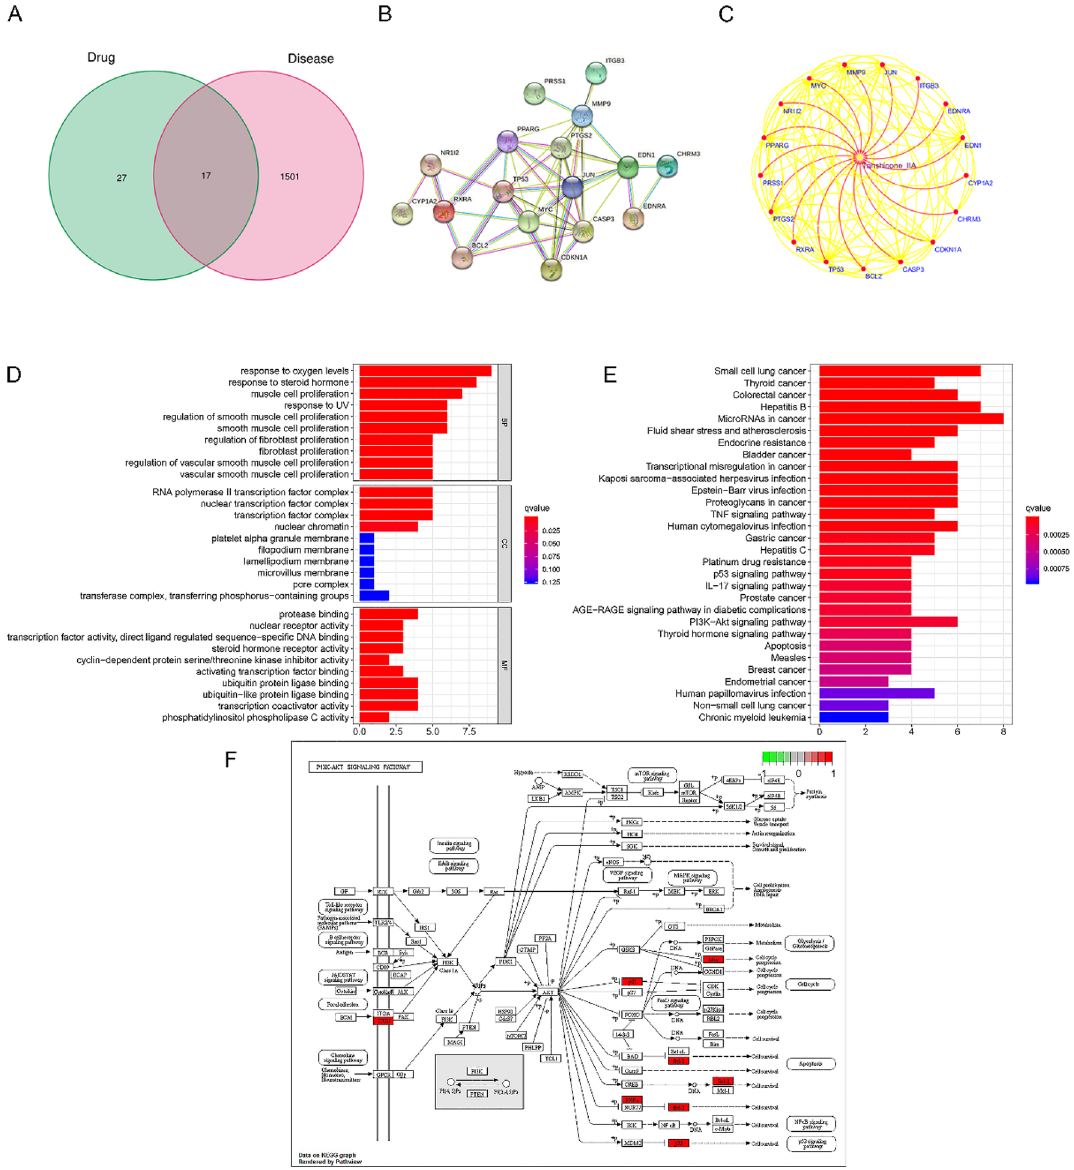
Figure 2. Identifying common targets for Tan-IIA and Cholangiocarcinoma. ( A ) Venn diagrams were created by using the VennDiagram package 12 in R software (version number: 4. 0. 0), depicting the intersection of Tan-IIA and Cholangiocarcinoma targets. ( B ) PPI network was constructed using 17 common targets of Cholangiocarcinoma and Tan-IIA. ( C ) Cytoscape plotted the network pharmacology, using red and yellow lines to indicate the interactions between Tan-IIA and targets and target-to-target interactions. GO and KEGG analysis of common targets. ( D ) GO functional enrichment was ran by using the clusterProfiler package 14 in R software (version number: 4. 0. 0) and GO analysis of the enriched biological functions of the common target genes was performed (counts ≥ 30). ( E ) KEGG 15,16 analysis of signaling pathways enriched by common target genes (counts ≥ 30). ( F ) Map of PI3K/AKT pathway obtained from KEGG